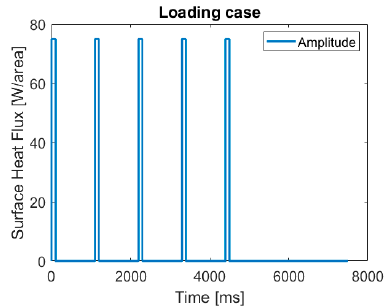
Figure 4. Thermal loading and unloading steps.